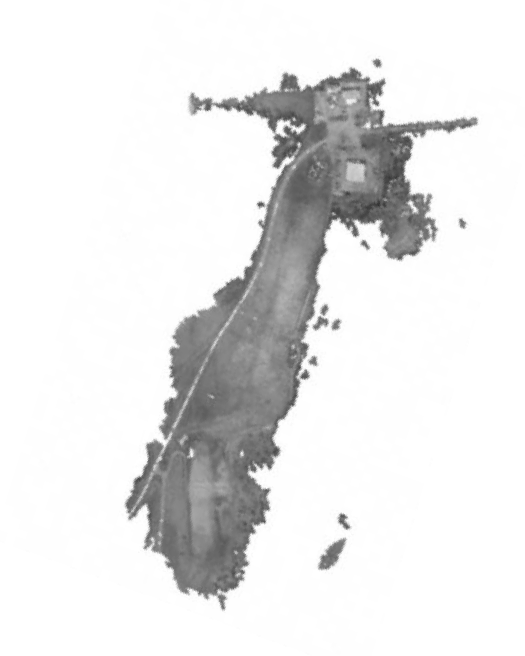
Figure 6. Dense point cloud created by VisualSFM, CMVS and PMVS from multiple flights over part of the northern test areas using the NGA quadcopter with a GoPro flat lens camera 4.